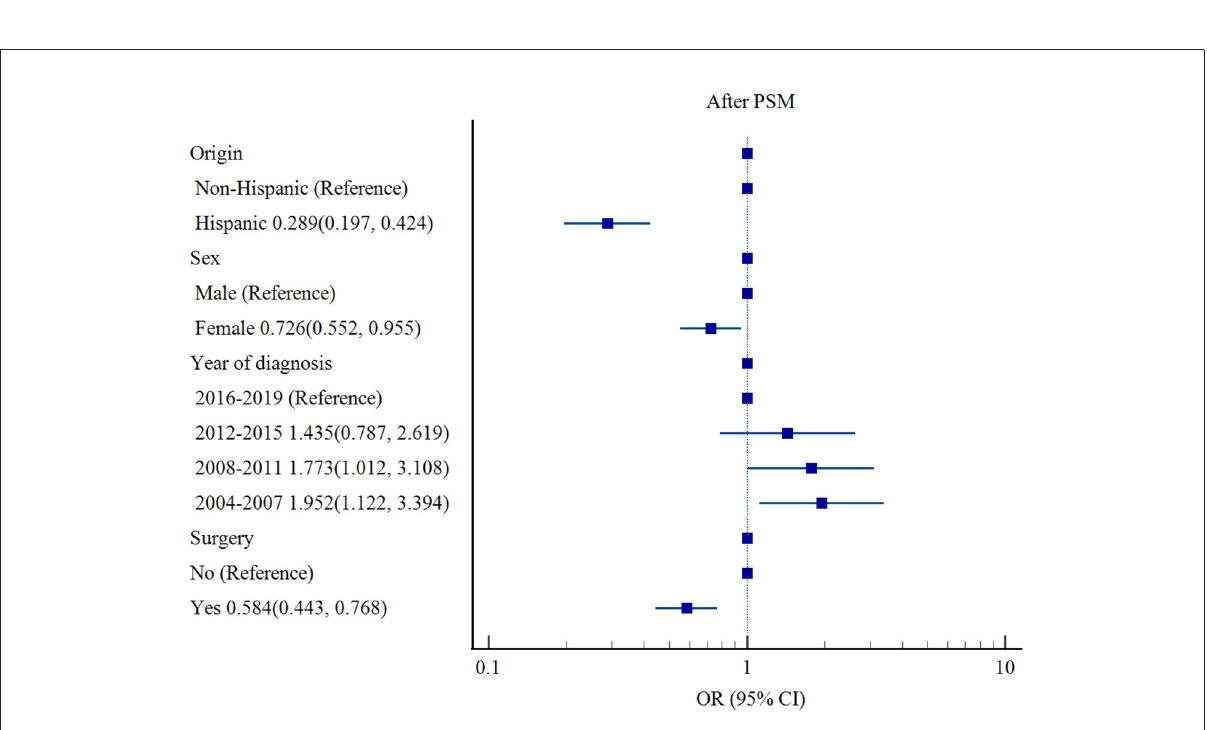
FIGURE3 Influencing factors of cardiac-specific death in patients with non-malignant tumors of CNS receiving RT after